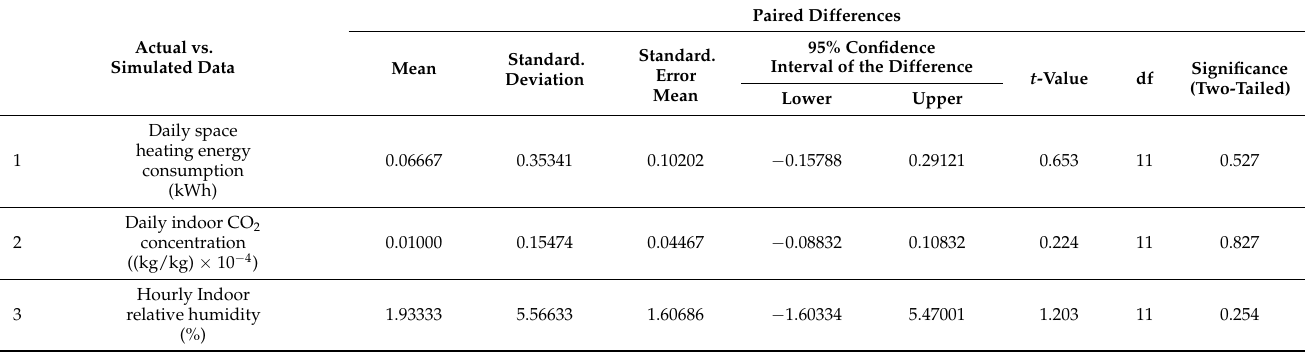
Table 4. Paired sample difference t -test results between actual and simulated data for space heating energy consumption, indoor CO 2 concentration, and indoor relative humidity (RH) in 2020 for cases of leaky fans on in Montreal. Paired Differences 95% Confidence Actual vs. Standard. Interval of the Difference Simulated Data Mean Standard. Error t -Value Deviation Mean